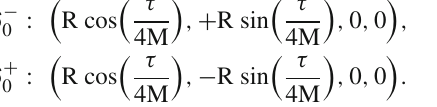
Fig. 8 Two-dimensional representation for t 0 = 0, of the 2d surfaces δ − δ + ρ and ρ emmbeded in four dimensions. No red slice appear in this case